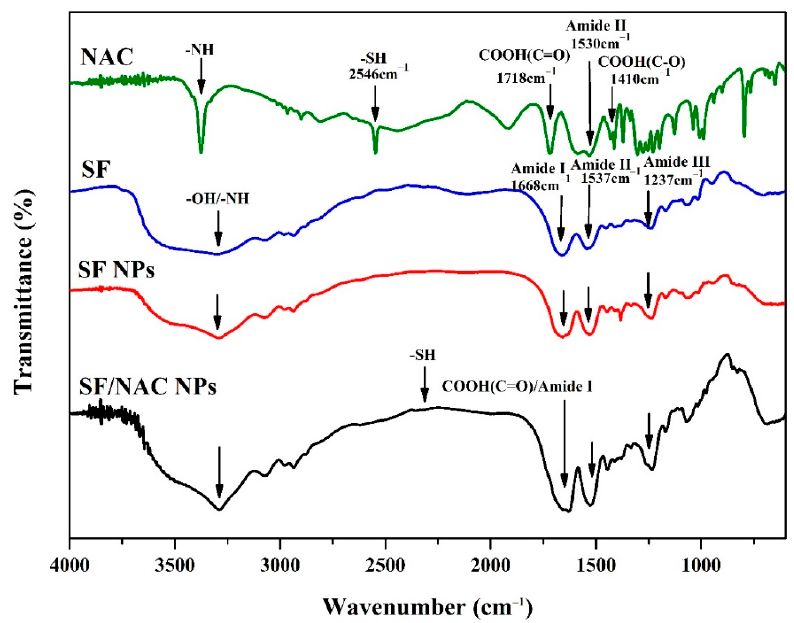
Figure 2. ATR-FTIR transmission spectra for analyzing functional groups for NAC, SF and SF/NAC NPs. The characteristic peaks for amide I, II and III (e.g., 1231 cm − 1 ) in the SF spectra were also presented in the spectra for SF and SF/NAC NPs but the amide I peak for SF NPs was shifted from 1668 cm − 1 to 1650 cm − 1 for the spectra for SF/NAC NPs, possibly due to the chemical interaction between carboxyl groups (-COOH) in NAC and Amide I of SF.